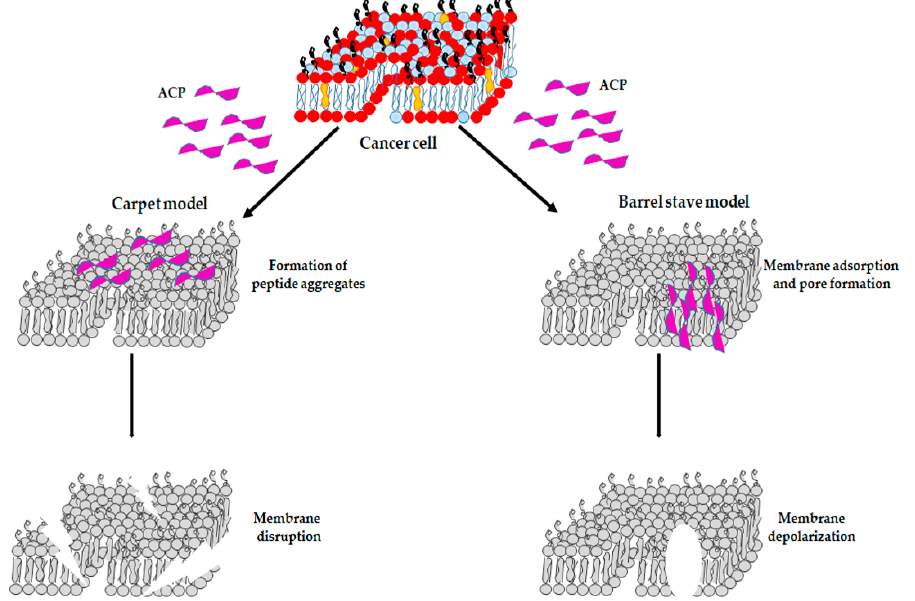
Figure 3. Models of ACPs’ action. In the carpet model ( left ), ACPs bind to the cell membrane via electrostatic interactions and, subsequently, ACPs may enter the cell membrane, inducing membrane disruption. In the barrel-stave model ( right ), peptides self-aggregate and form a transmembrane pore, leading to membrane depolarization.